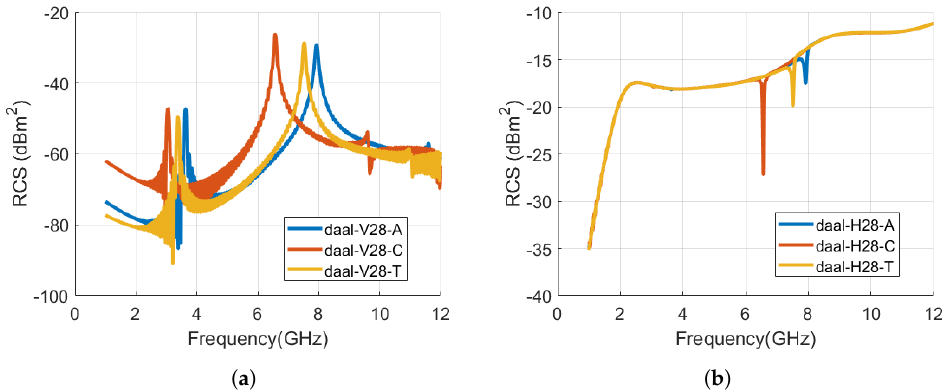
Figure 10. Comparison of RCS results of alphabet X tag with various font types (Arial, Calibri, and Times New Roman) with font size of 28: ( a ) Vertical polarization; ( b ) Horizontal polarization. Table 2. Signature resonance frequencies for letter X tag with various font types (Arial, Calibri, and Times New Roman) with the font size of 28.